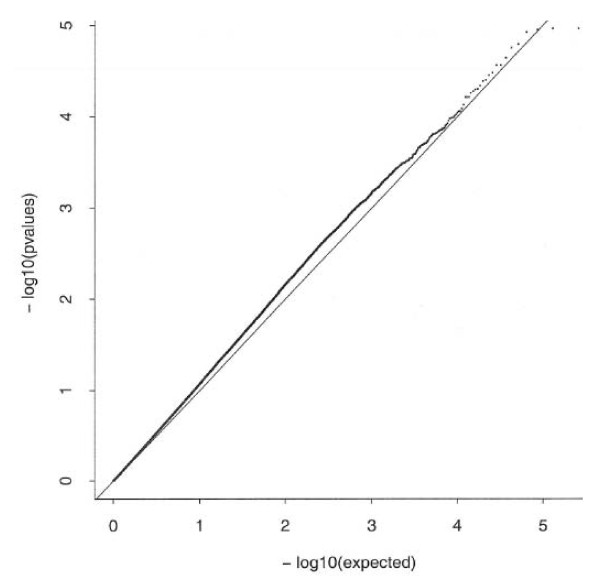
Quantile plot of observed versus expected p-values (on the logarithmic scale) for the associations between the combinations formed from each possible pair of SNPs and rubella antibody levels. While the observed p-values depart somewhat from the line of unity, they do not follow a pattern that suggests the presence of major epistatic effects.